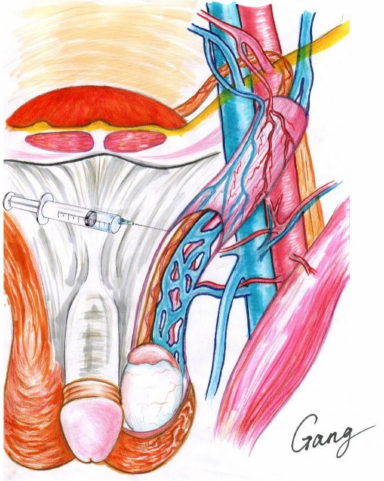
Figure 2. Local anesthesia of microscopic